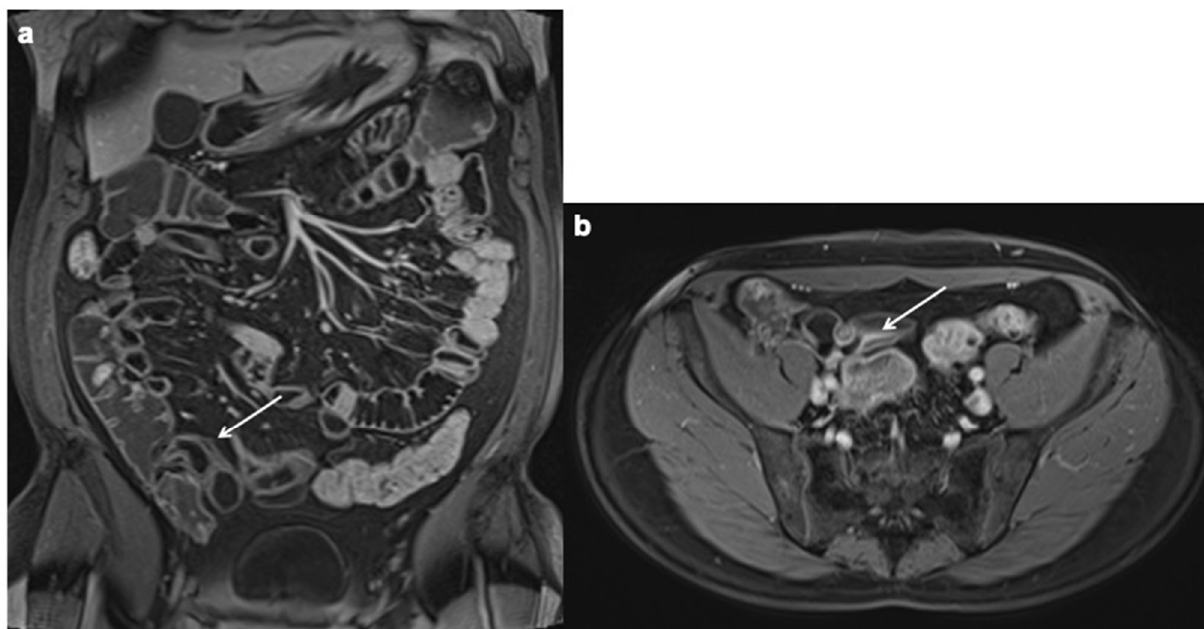
Figure 13. Coronal and axial contrast-enhanced fat-suppressed T1 weighted enteric phase ( a , b ) detect small bowel wall thickening in the terminal ileum with intramural fat deposition (white arrows), representing no signs of active inflammation.